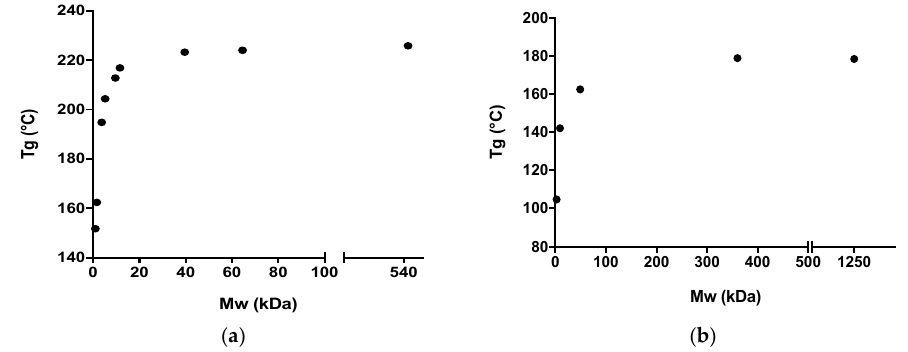
Figure 1. Correlation between the T g (°C) and the M w (kDa) for ( a ) different dextran grades and ( b ) different PVP grades. The T g values for the different dextran grades were obtained from [13].